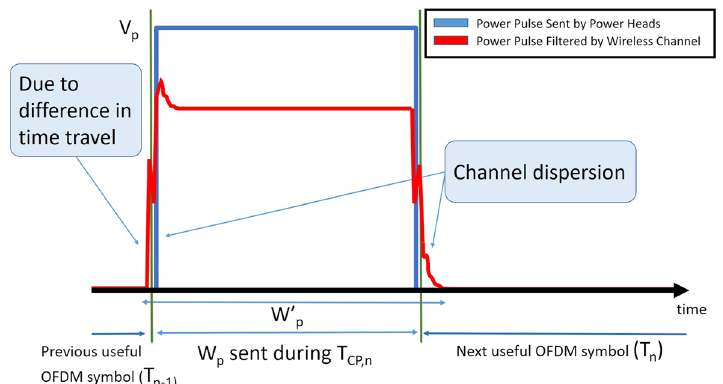
Fig. 4 Effect of Wireless channel dispersion of the power signal onto the previous and successive useful OFDM